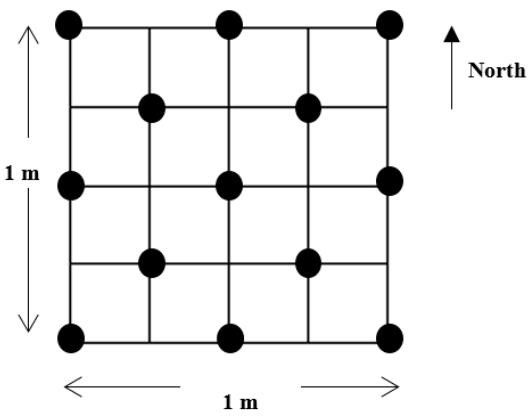
Figure 3. Measurement scheme for canopy height. Thirteen locations (dark dots) were measured in each quadrat to derive the mean, maximum, and minimum values.